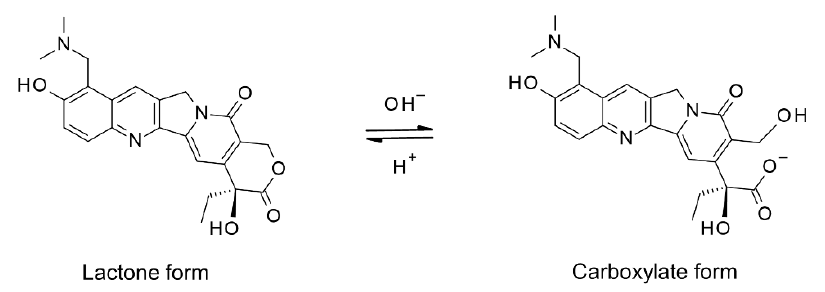
Figure 1. Reversible hydrolysis of Topotecan lactone ring.